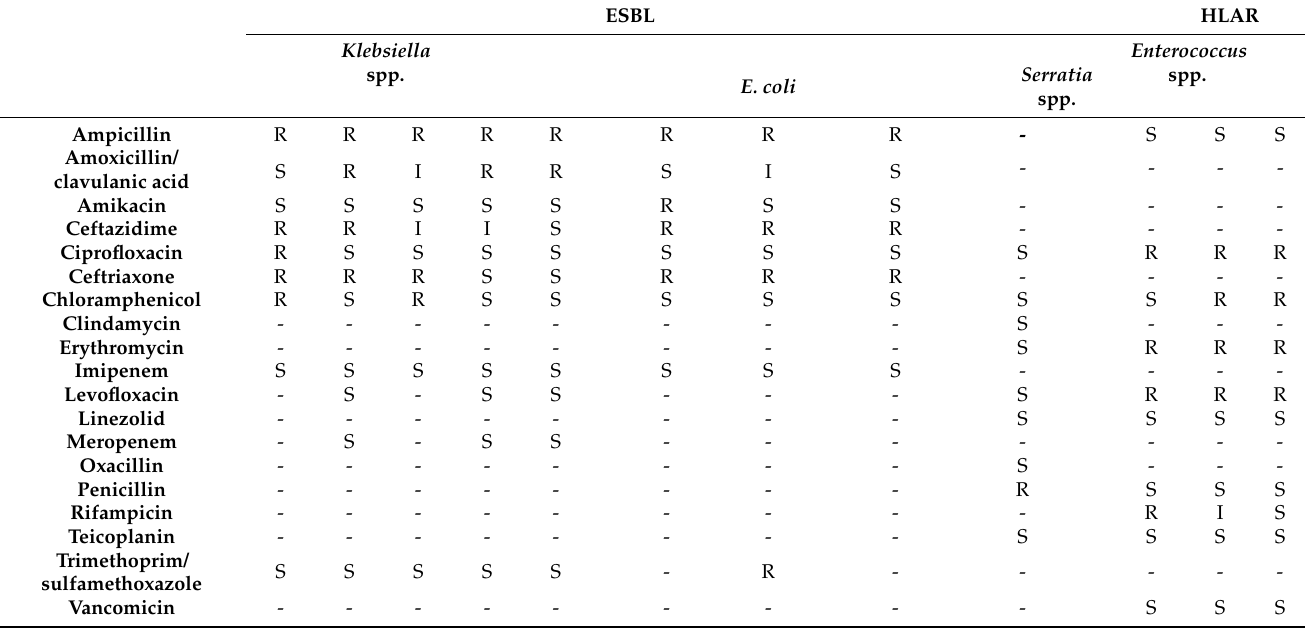
Table 10. Antibiotic resistance of the Gram-negative producing extended-spectrum beta-lactamases (ESBL) and Enterococcus spp. (HLAR) strains, isolated from hospitalization samples. ESBL HLAR Klebsiella spp.